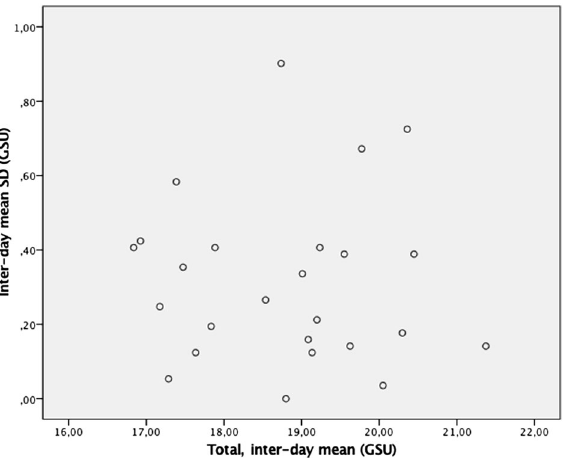
Figure 2. Mean standard deviation in the total densitometry plotted against the mean interday values of total densitometry for the keratoconus